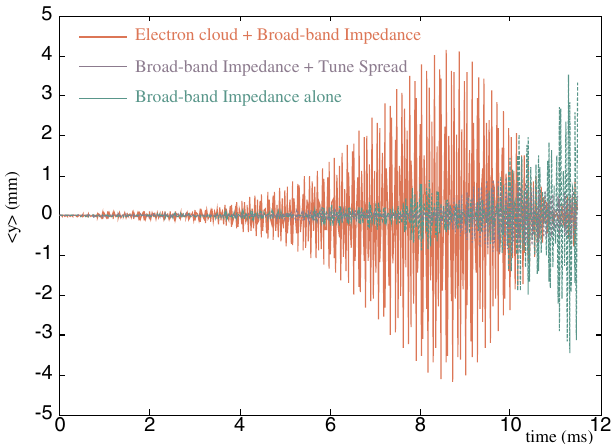
FIG. 52. (Color) Evolution of the centroid vertical position of an SPS bunch over 500 turns considering the combined effect of electron cloud and broadband impedance (red), the effect of broadband impedance and an additional space-charge tune spread (blue), and the broadband impedance alone (green) [41]; the simulation was performed with HEADTAIL .